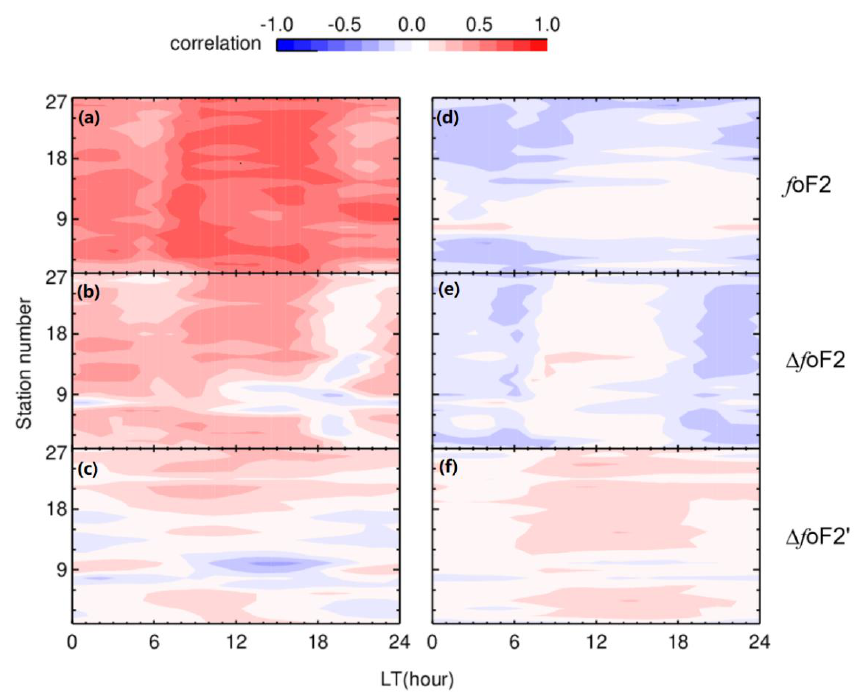
Figure 2. ( left panels ) Correlation coefficient (CC) between solar activity index F10.7 and ionospheric observation f oF2 (panel a ) or the residual of fo F2 (∆ fo F2 (panel b ) and ∆ fo F2’ (panel c )) at different local times. ( right panels ) CC between geomagnetic index Ap and f oF2 (panel d ) or residual fo F2 (∆ fo F2 (panel e ) and ∆ fo F2’ (panel f )).